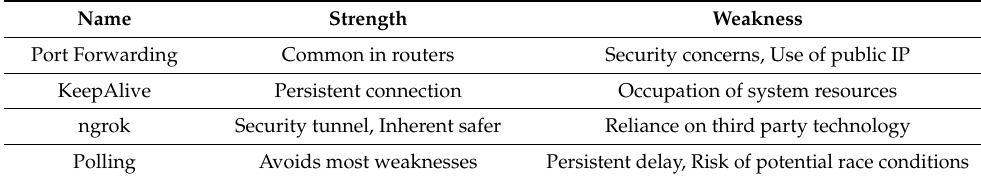
Table 1. Proven technologies that can meet direct connectivity.